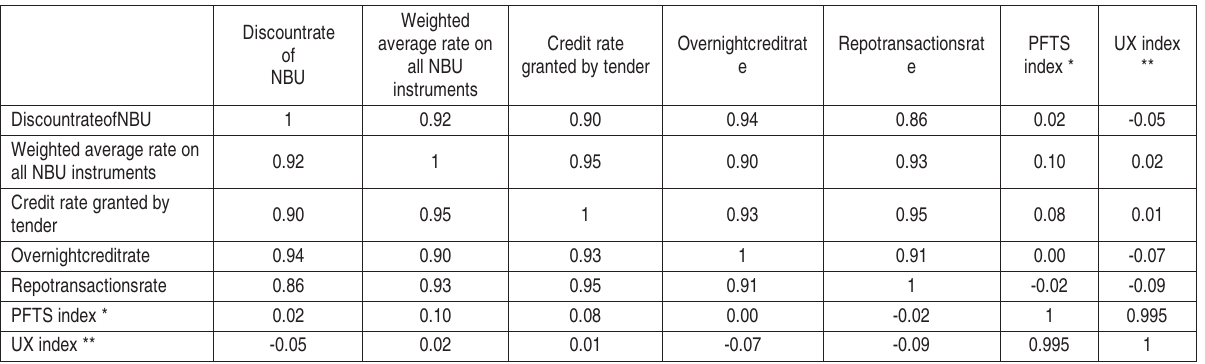
Table 1. Correlation matrix characterizing the Ukrainian stock market reactions to the changes of monetary policy instruments (monthly data) Weighted Discountrate average rate on of all NBU NBU instruments DiscountrateofNBU